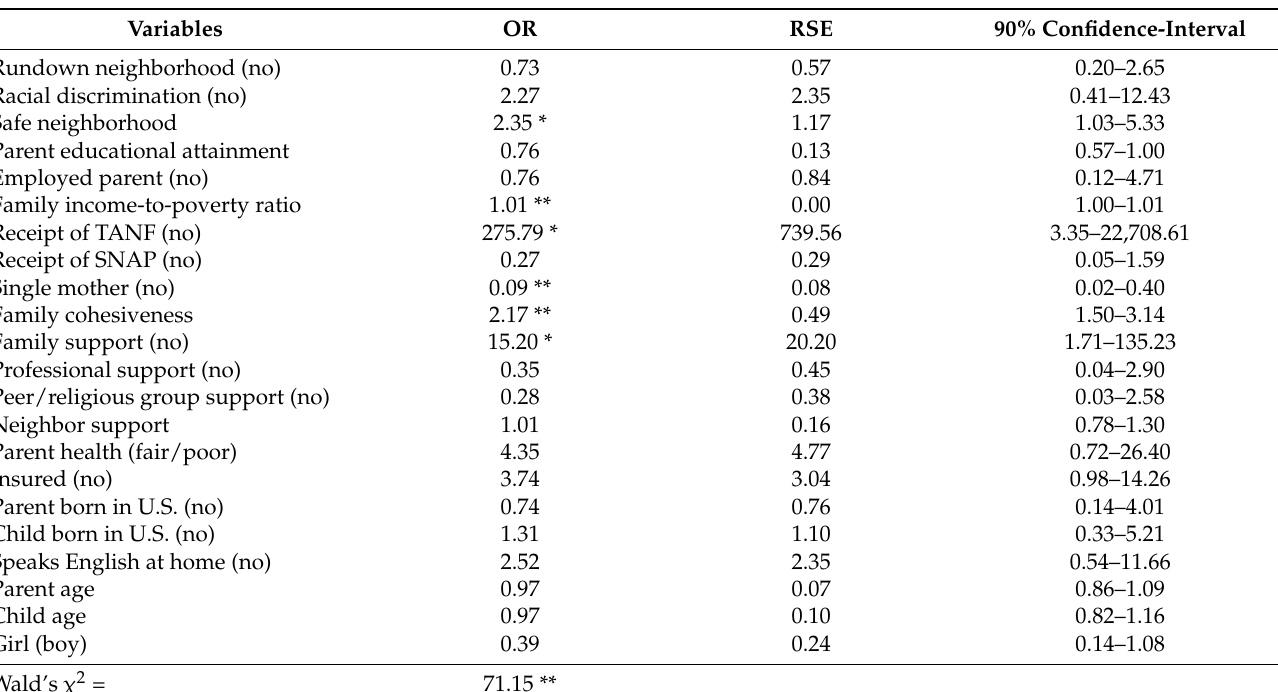
Table 2. Logistic regression results on ethnic Asian child health (excellent/very good/good) ( n =